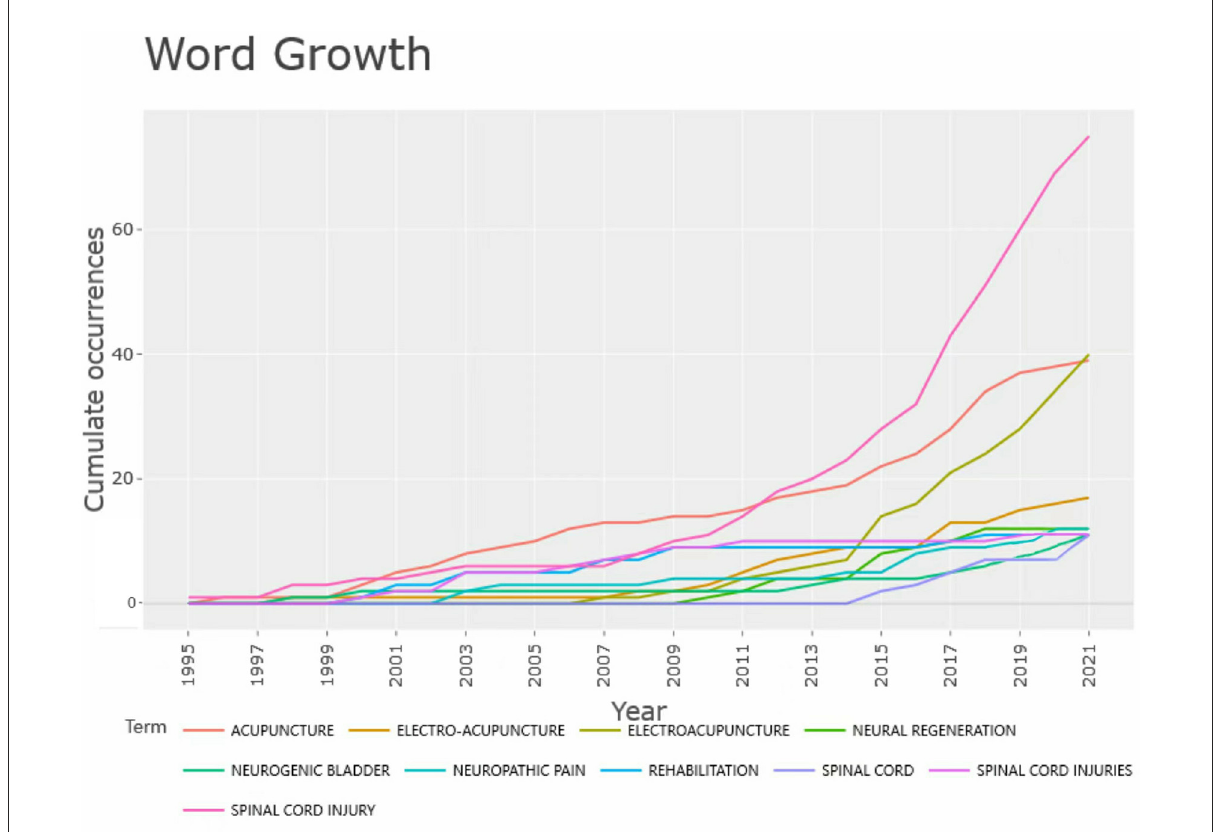
FIGURE7 Trends (with Loess Smoothing) in the top 10 author keywords in acupuncture for SCI.